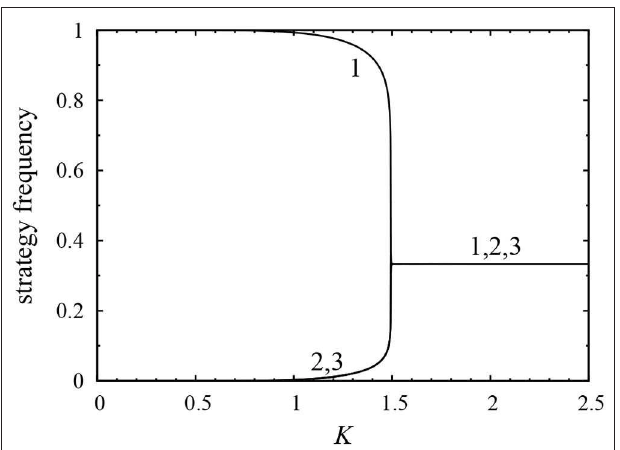
FIGURE 3 | Strategy frequencies vs. K in one of the three equivalent stationary states of the three-strategy Potts model defined by Equation (24).